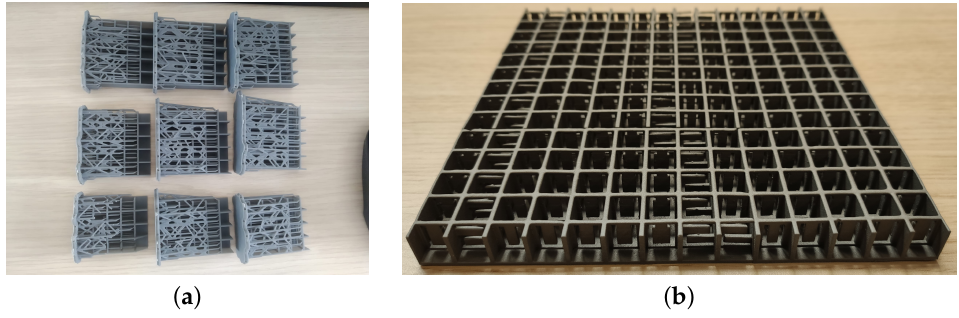
Figure 6. ( a ): Photo of the individual pieces including the supports. ( b ): Photo of the final RA prototype. The S- and C-shaped resonators can easily be